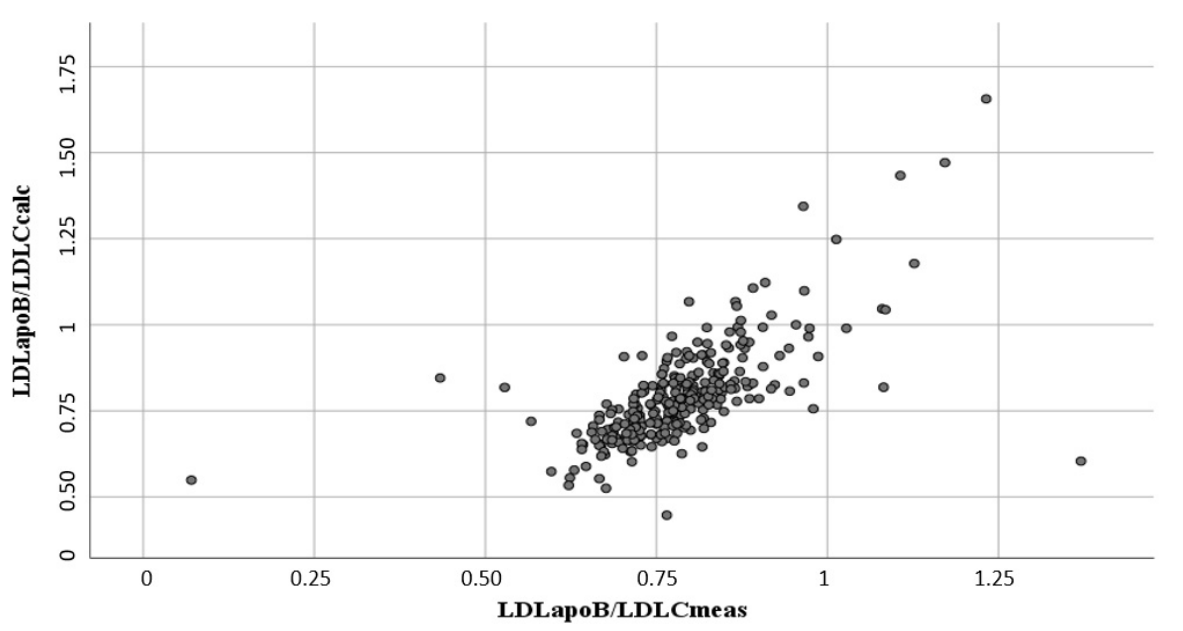
Figure 1. Association between LDLapoB/LDLC meas and LDLapoB/LDLC calc in the LURIC cohort. Legend: for each patient one grey circle. 3.3. LDLapoB/LDLC meas and LDLapoB/LDLC calc Ratio and Cardiovascular Mortality A total of 621 cardiovascular deaths occurred during the follow-up. The quartiles of LDLapoB/LDLC meas were positively related to cardiovascular mortality (Figure 2) ad- justed for sex, age, statin treatment, and interaction between statin treatment and LDLapoB/LDLC meas quartiles (Table 2) . The association of the LDLapoB/LDLC meas quar- tiles with cardiovascular mortality remained significant after multivariate adjustment (Ta- ble 2). There was significant interaction between LDLapoB/LDLC meas quartiles and statin use in predicting cardiovascular mortality ( p = 0.030). Stratified analyses revealed that quartiles of LDLapoB/LDLC meas ratios were strongly and positively associated with cardi- ovascular mortality in statin-naïve patients adjusted for sex and age and after multivariate adjustment (Table 2). In contrast, quartiles of LDLapoB/LDLC meas ratios were not associ- ated with cardiovascular mortality in patients receiving statin treatment (Table 2). Con- sistent results were obtained for LDLapoB/LDLC calc ( Table 3). In agreement with the LURIC study, high LDLapoB/LDLC calc quartiles were associated with increased cardio- vascular mortality in the replication cohort (Supplementary Table S7). The sample size and the number of events were low for subgroup analyses.